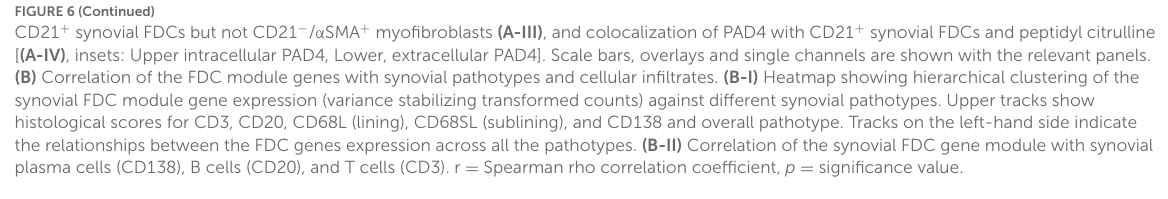
(ii) cultures stimulated with 300 ng/ml PDGF-BB for 24h